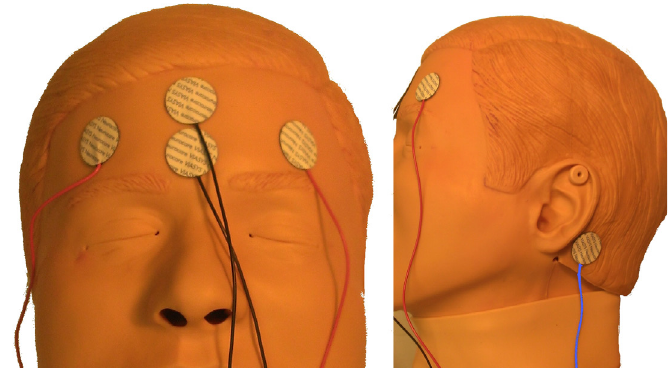
Figure 1 . Electrode